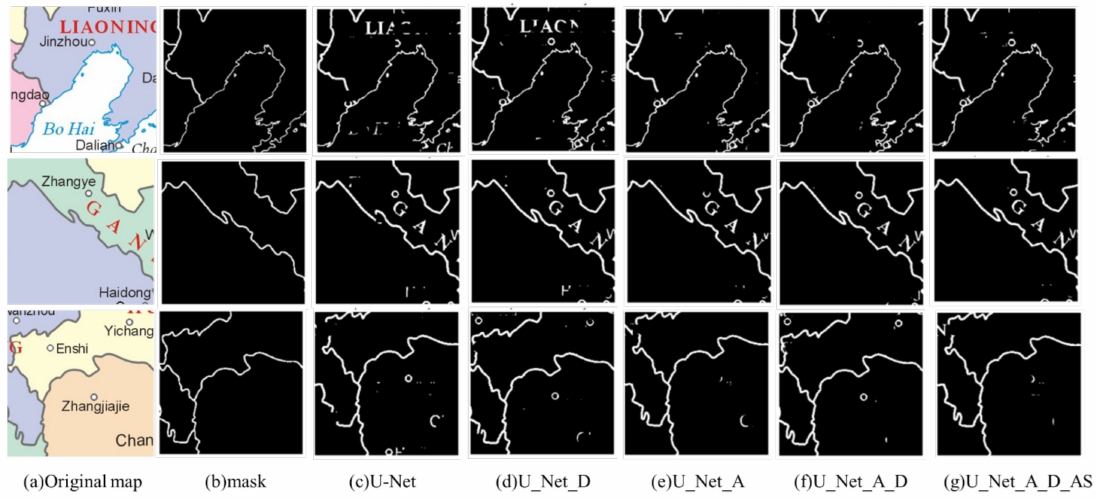
Figure 9. Extraction results of English character map: ( a ) cropped color map image blocks, ( b ) labels of map line features, ( c ) the U-Net result, ( d ) the U_Net_D result, ( e ) the U_Net_A result, ( f ) the U_Net_A_D result, and ( g ) the U_Net_A_D_AS